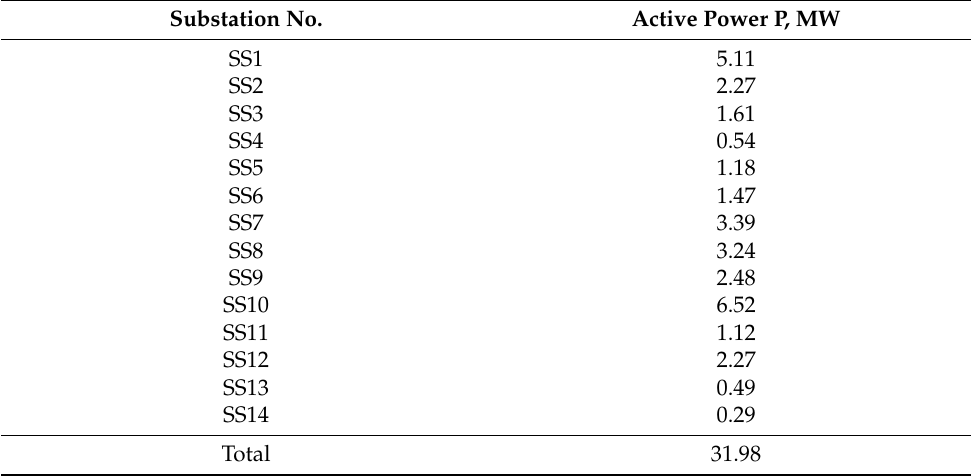
Table 1. Maximum loads at